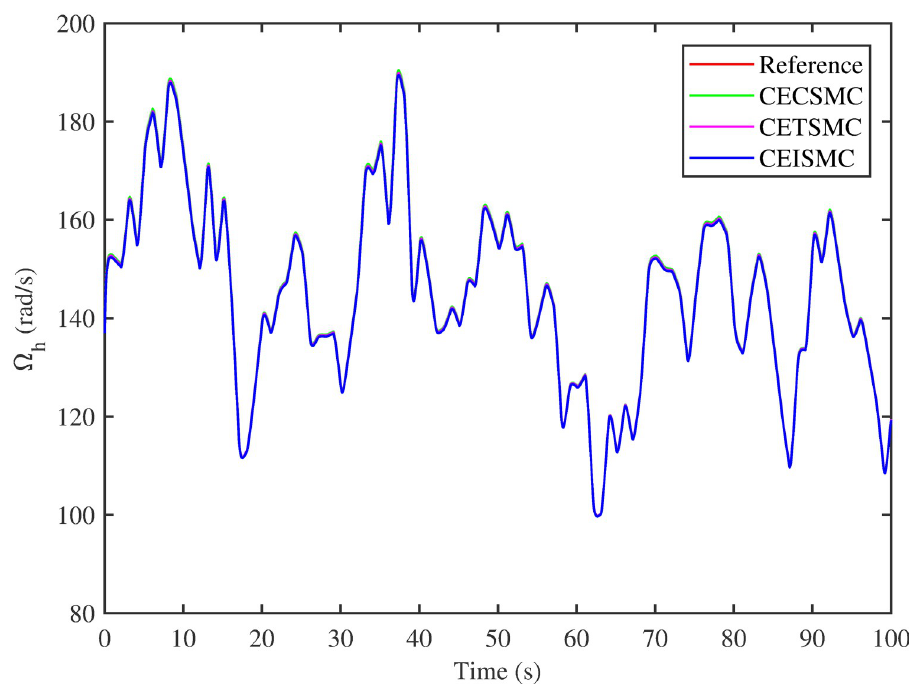
Fig 4. High speed shaft rotational